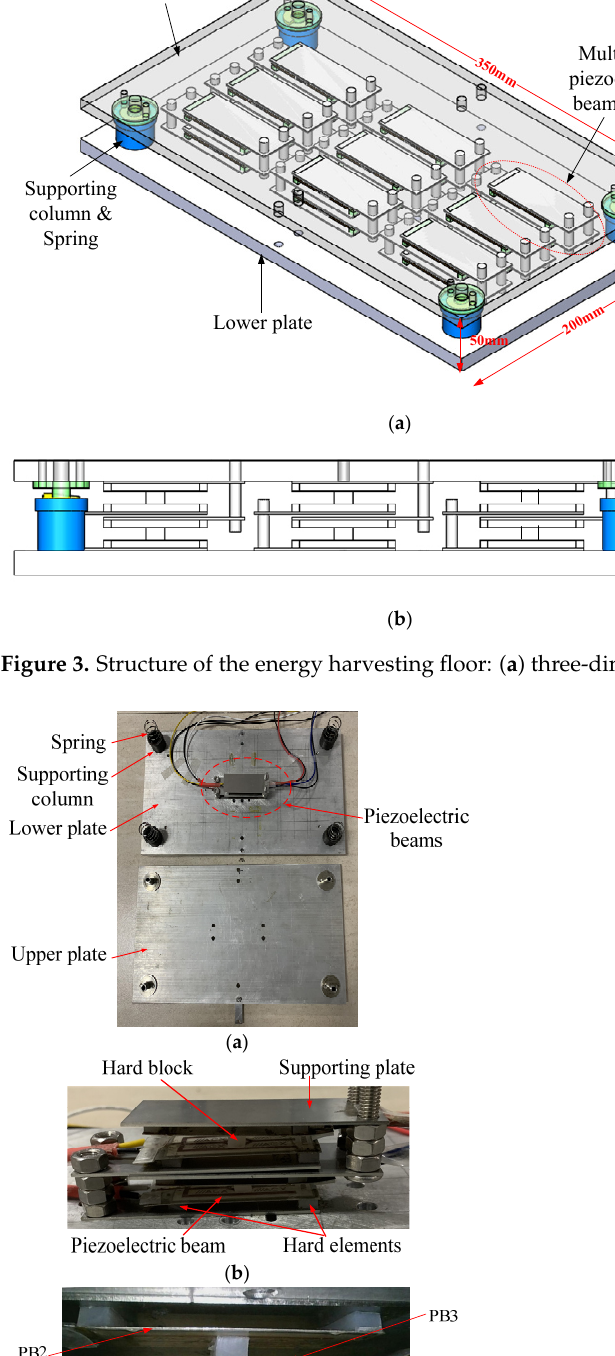
Figure 4. Prototype of energy harvesting floor structure: ( a ) whole view; ( b ) close-view of piezoe- lectric beams; ( c ) side-view of piezoelectric